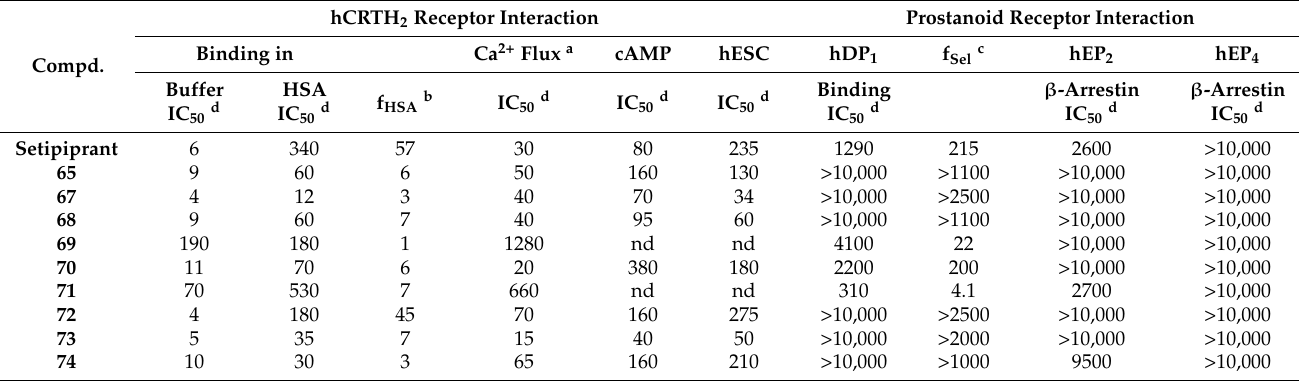
nd = not determined. a IC 50 values are given for the effects in the cell based Ca 2+ flux assay, the cAMP homogeneous time resolved fluorescence (HTRF) assay, and the human eosinophil shape change assay. Data are given to demonstrate selectivity against prostanoid receptors hDP 1 , hEP 1-4 , and hTP 2 . The IC 50 values represent the mean from at least three independent experiments if not stated otherwise. b Human serum albumin shift factor